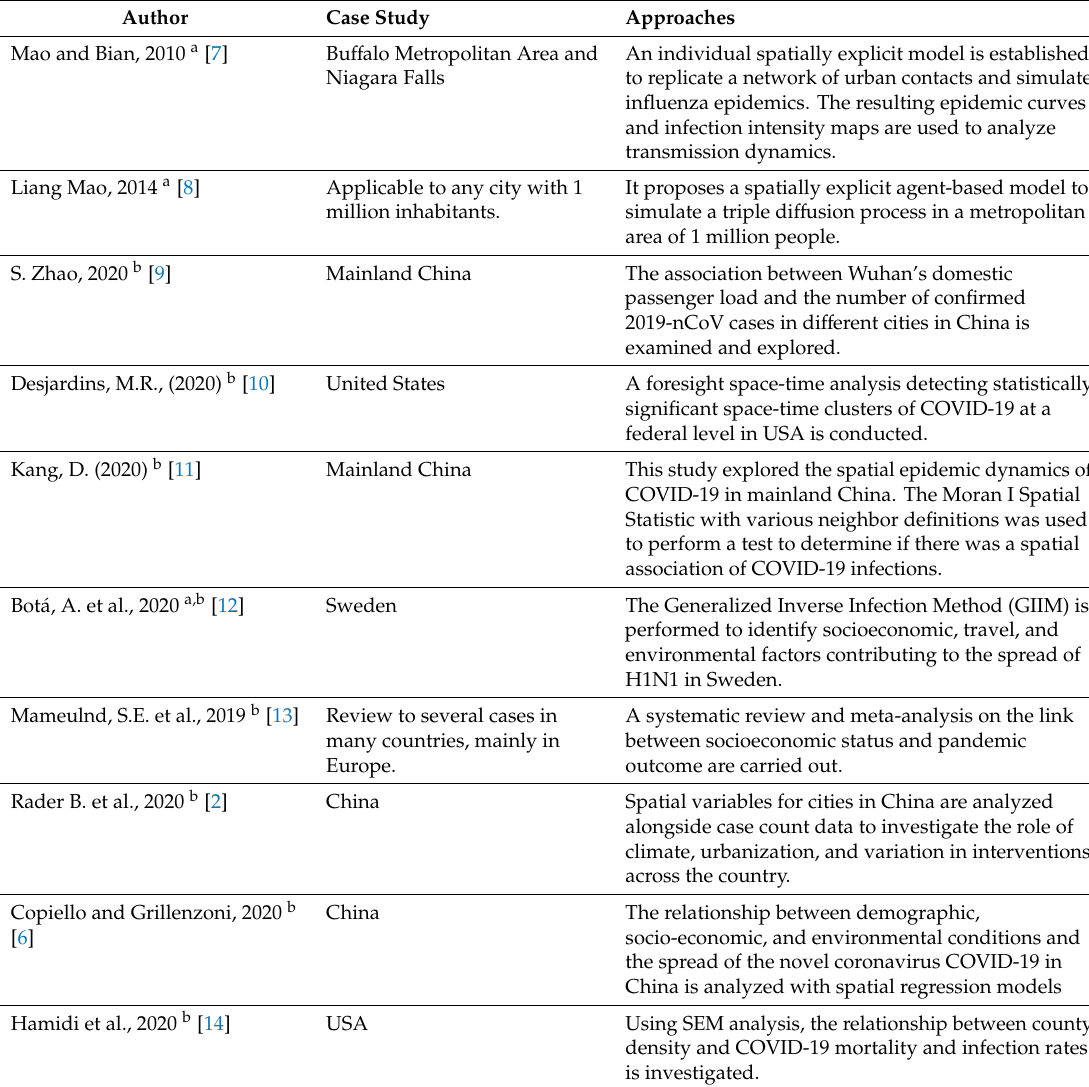
Table 1. Spatial approximations for the COVID-19 and other diseases